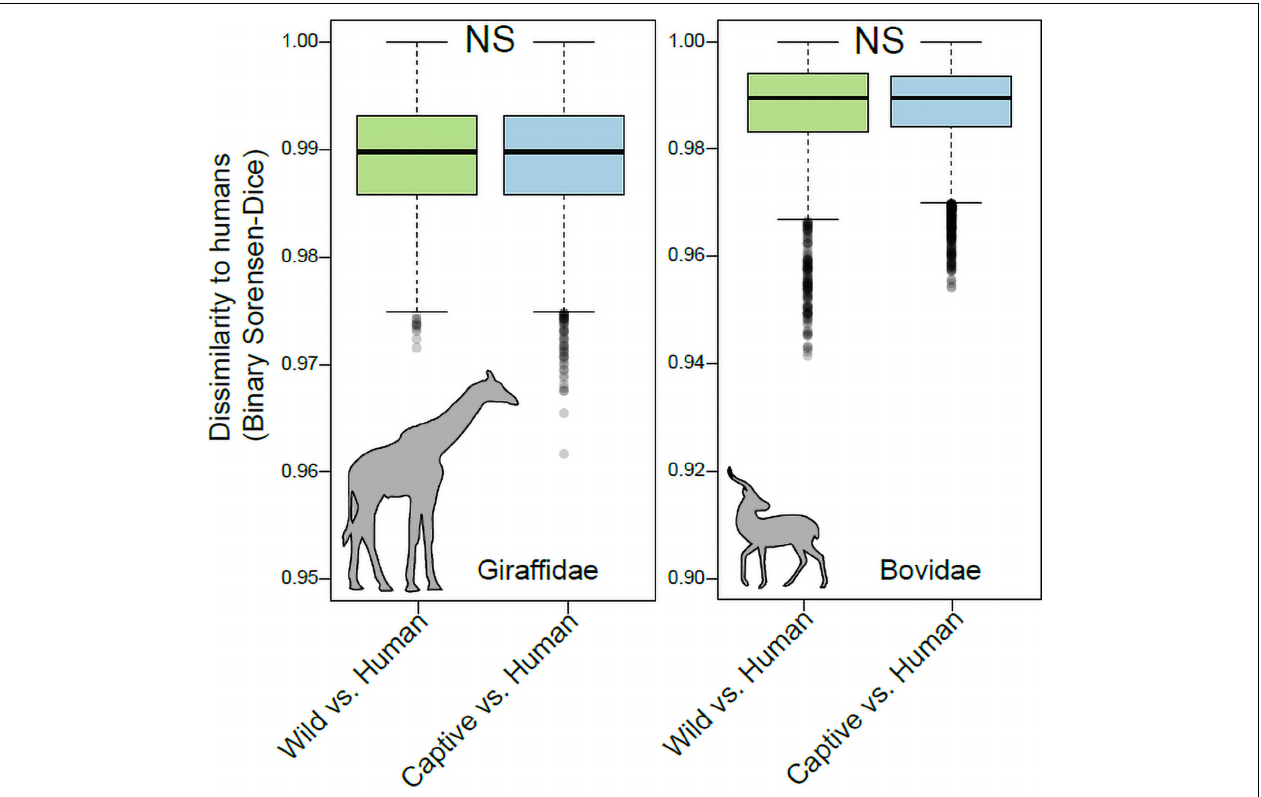
FIGURE 3 | Robustness to humanization of the gut microbiota in captive Giraffidae and Bovidae. Boxplots show microbiota dissimilarities (binary Sorensen-Dice) between humans and wild mammals (green boxes) and between humans and captive mammals (purple boxes). Each box shows median and interquartile range for a comparison including a single mammalian family. Significant differences between boxplots within each panel are denoted with asterisks; NS p > 0.05; non-parametric Monte-Carlo permutation